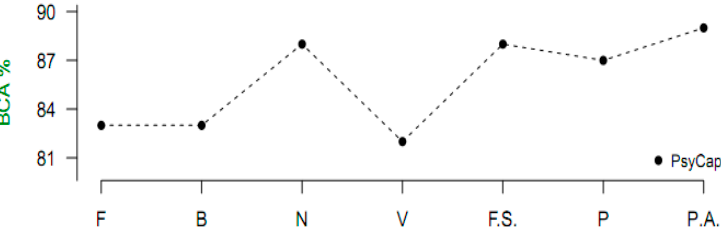
Figure 1. Balanced classification accuracy (BCA) results of the ranking algorithms of the PsyCap